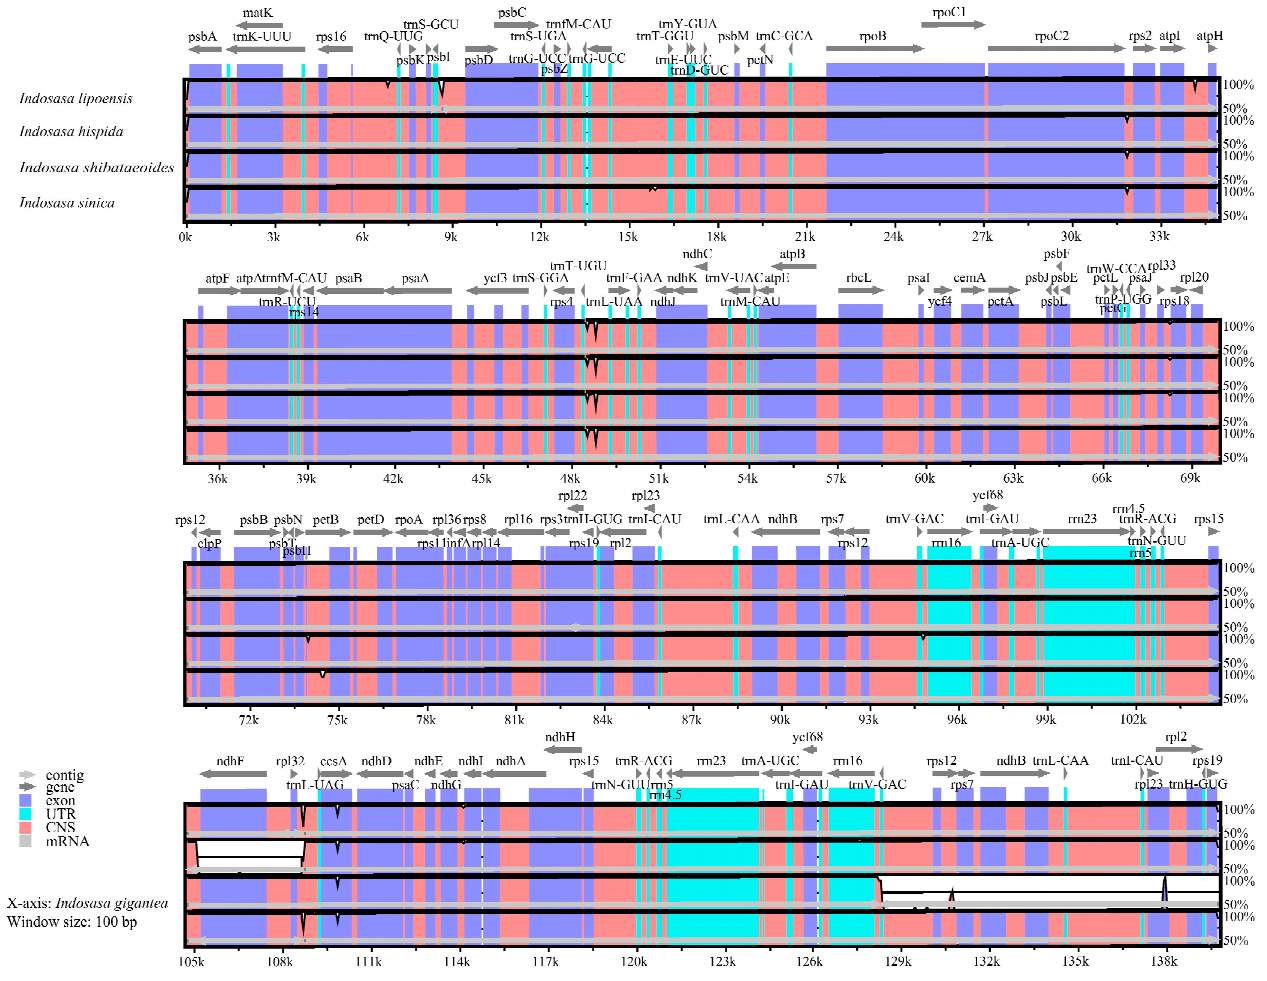
Figure 6. Comparison of five cp genomes from the Indosasa genus using mVISTA.